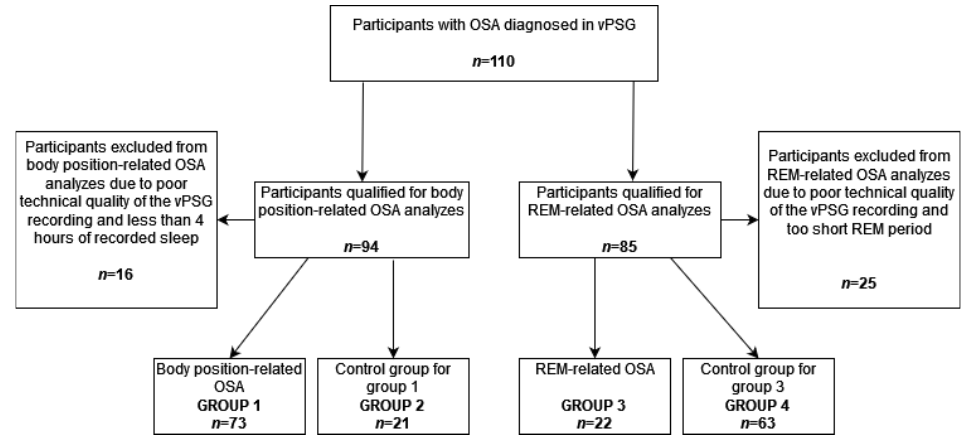
Figure 1. The scheme of study participants qualification to particular study groups. OSA — obstructive sleep apnea, REM — rapid eye movement, vPSG — video polysomnography.